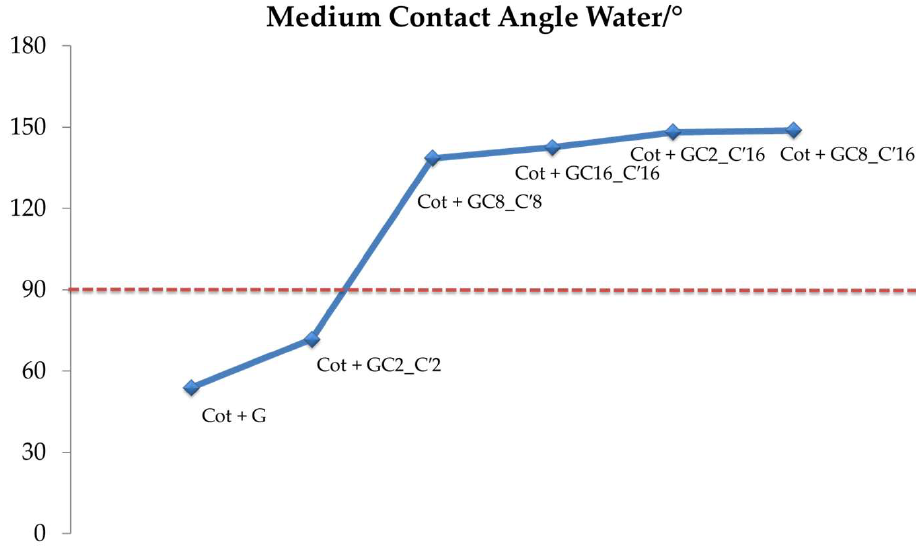
Figure 7. Schematic graph representative of the static water-contact angles of Wenzel θ w values. The line between the data points is only a guide for the